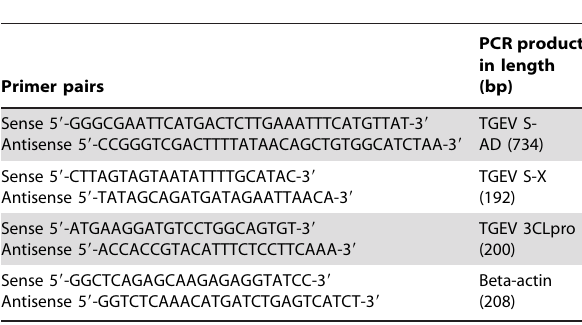
Table 1. Information on primers and RT-PCR products.